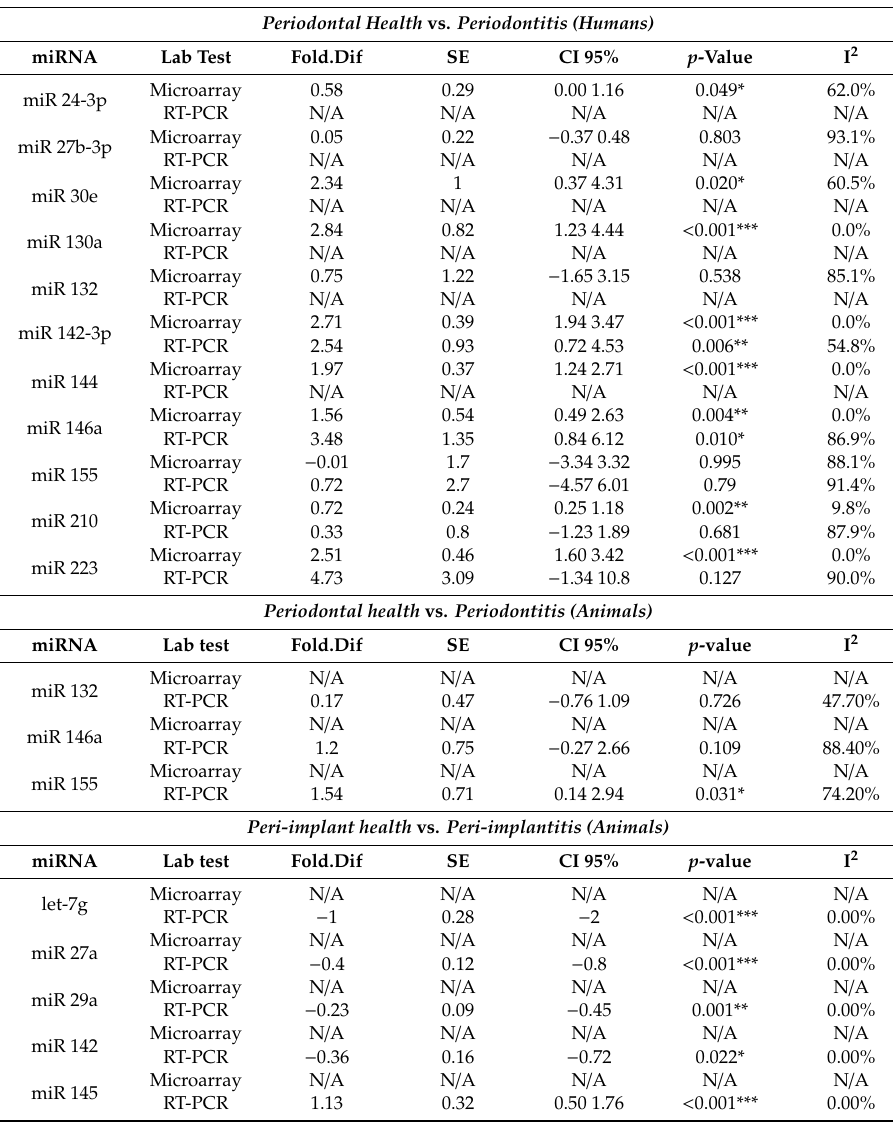
Table 1. Summary of meta-analysis on microRNAs (miRNA) expression between microarray and real-time polymerase chain reaction